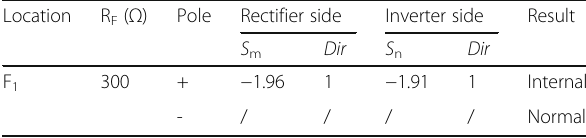
Table 1 Simulation results for a fault at F 1